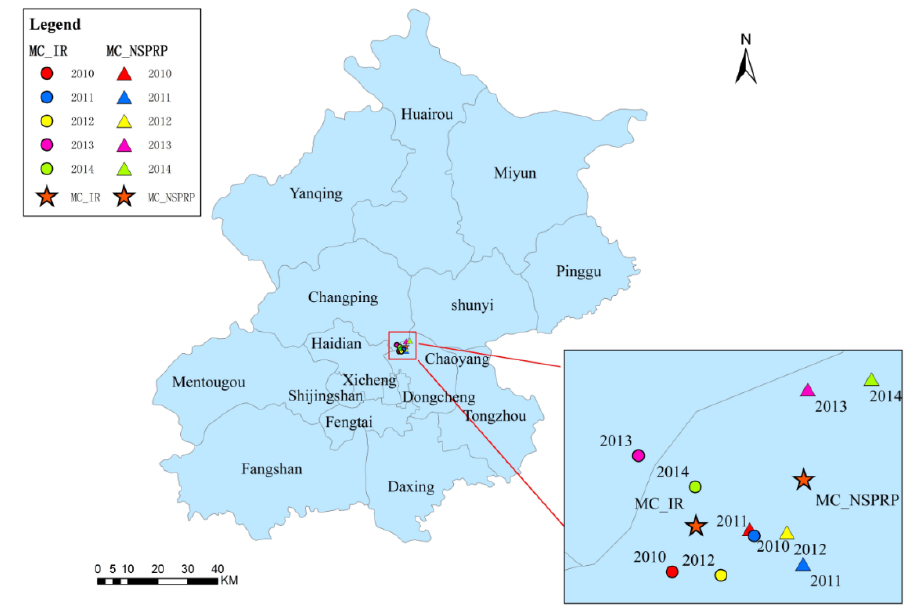
Figure 7. The distributions of IR and NSPRP MCs in Beijing from 2010 to 2014.